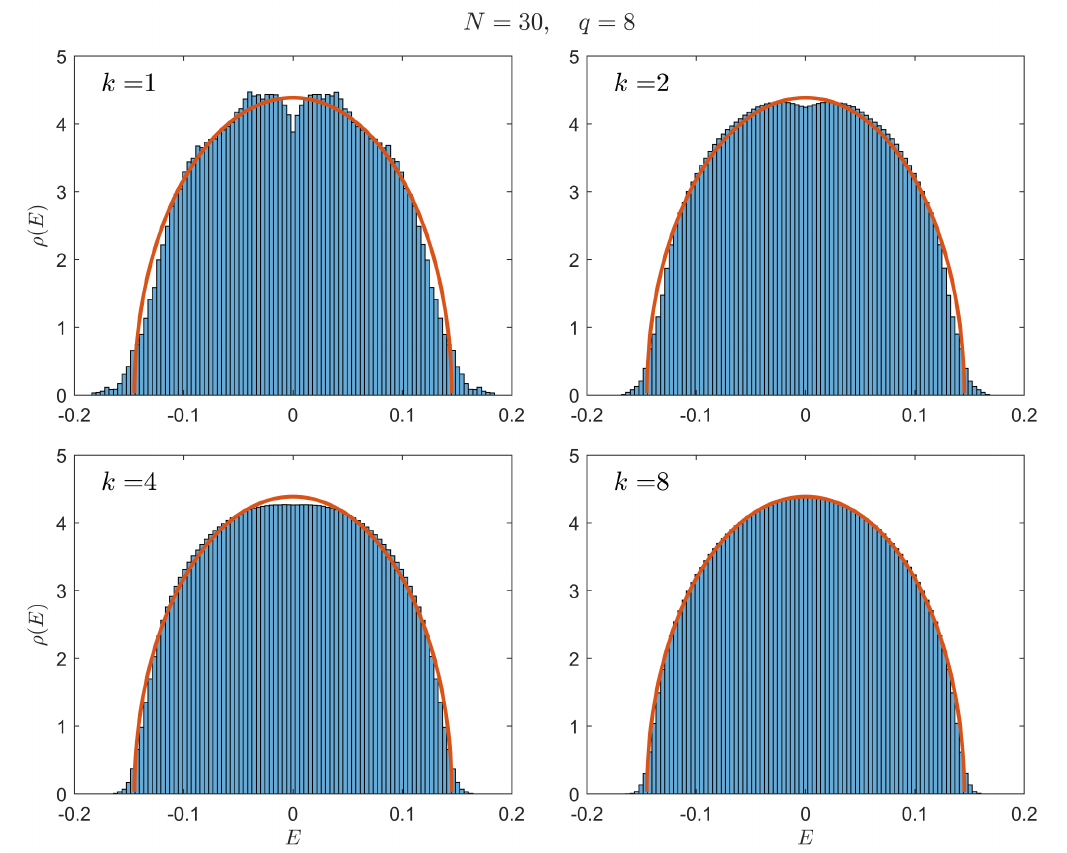
Figure 9 . A histogram of the spectral density of the sparse SYK Hamiltonian averaged over 100 disorder realizations for various values of k . For comparison the solid red line is the Q –Gaussian approximation to the spectral density